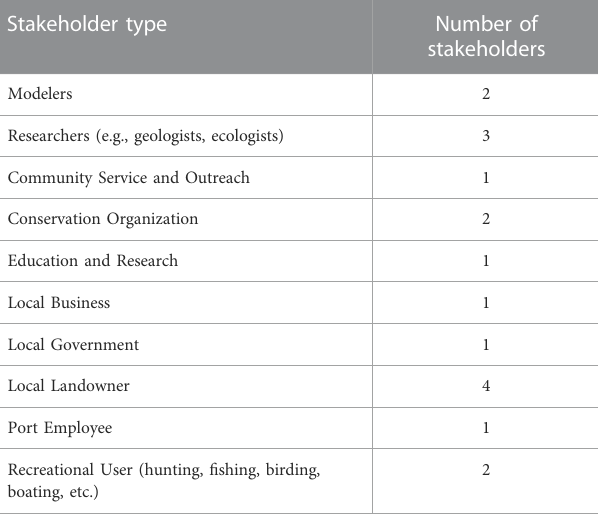
TABLE 1 Stakeholders who participated in the ECG by